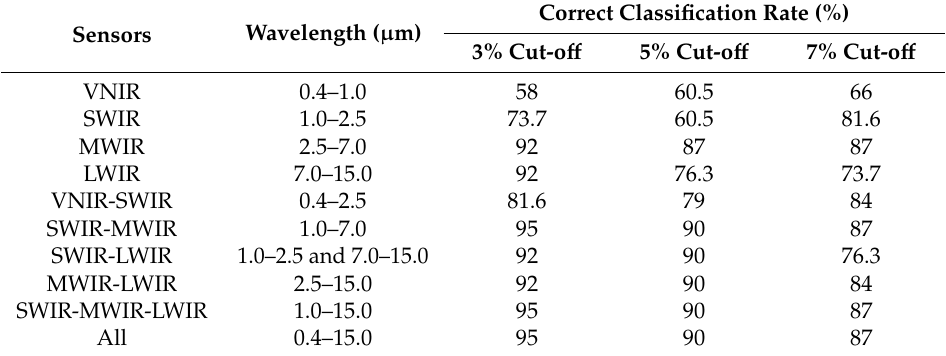
Table 5. Summary of the correct classification rates when the SVC classifier is applied to the individual and fused data blocks. The ore − waste classification rates for the three cut-o ff grades are indicated for each data model. The wavelength range indicates the operating wavelength range of the